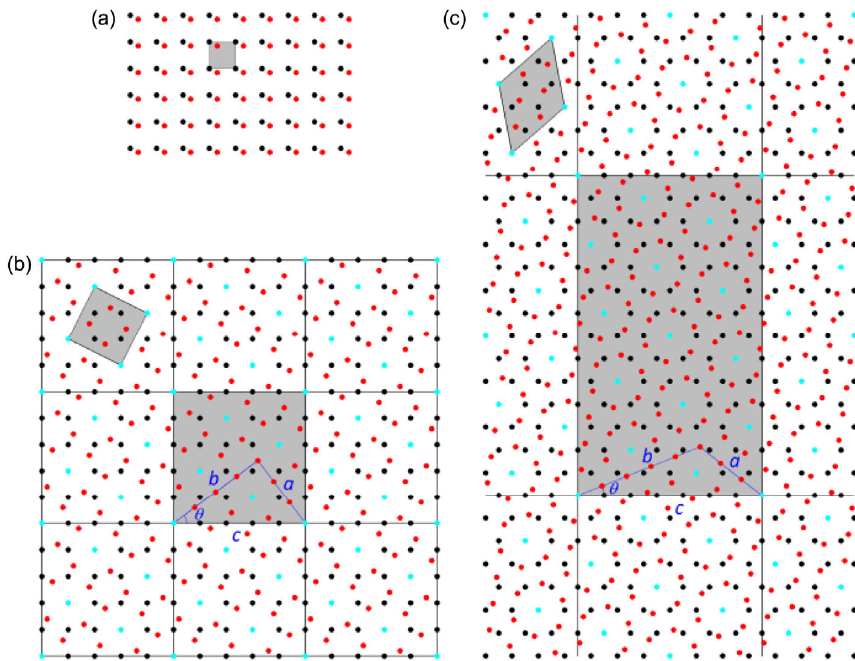
Fig. 1 Commensurate contact between two identical crystalline surfaces. The lattices on two contact surfaces are shown in black dots (lower), red dots (upper) and blue dots (overlapped), respectively. (a) The trivial commensurate case in square lattice. In this case, the orientation is exactly the same ( θ = 0°). The grey square area is the smallest repeat unit. (b, c) A nontrivial commensurate case in square/hexagonal lattice. The grey square area in the center is obviously repeated periodically (attention: the smallest repeat unit is the smaller grey square area shown in the upper left corner). The case of ( a , b , c ) = (3, 4, 5)/(3, 5, 7) is shown here.